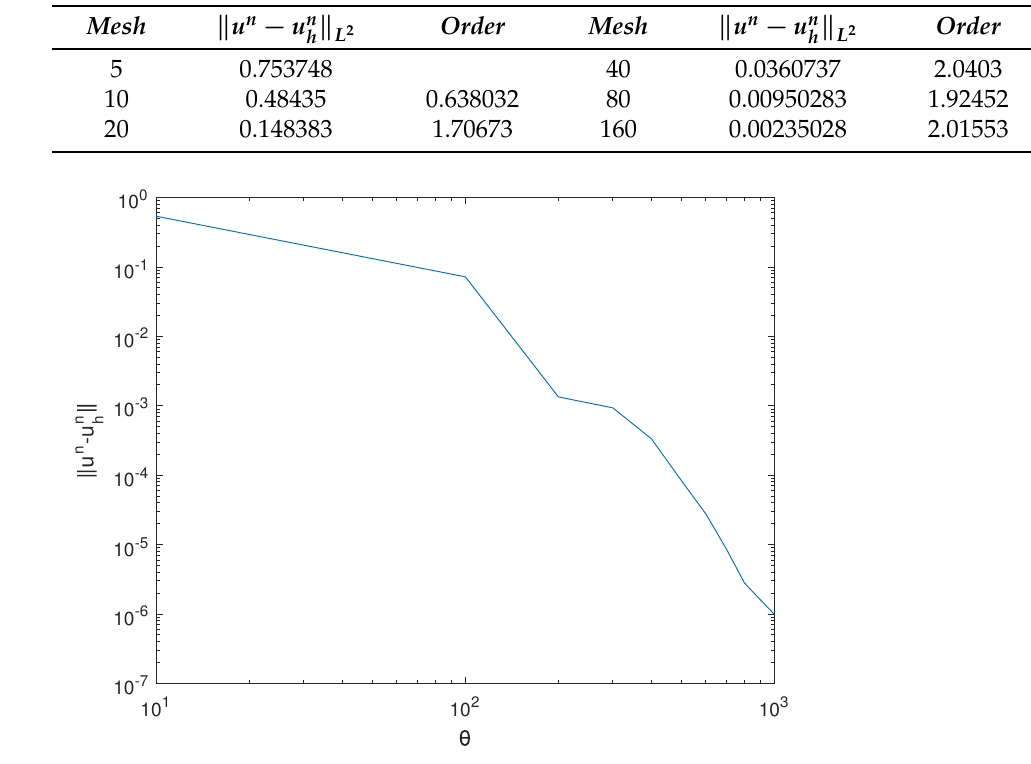
= 1 with respect to θ for